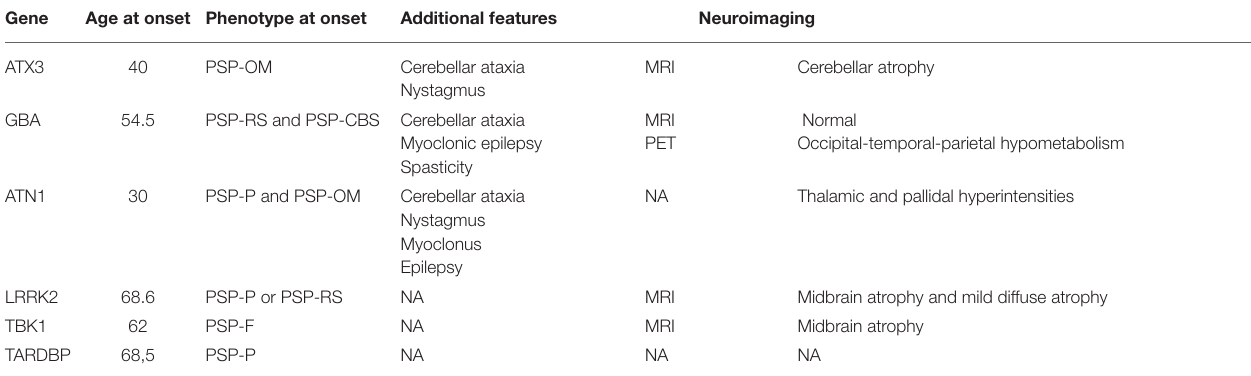
TABLE 2 | Genes rarely associated with PSP phenotype of monogenic origin.